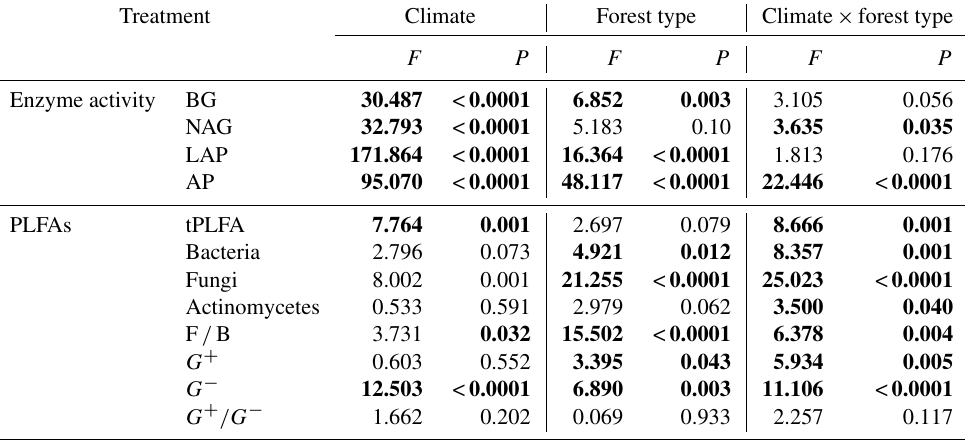
Table 2. The effect of forest types and climate on the soil enzyme activities and PLFAs. The bold font means that the effect of forest types and climate were significant. tPLFA: total